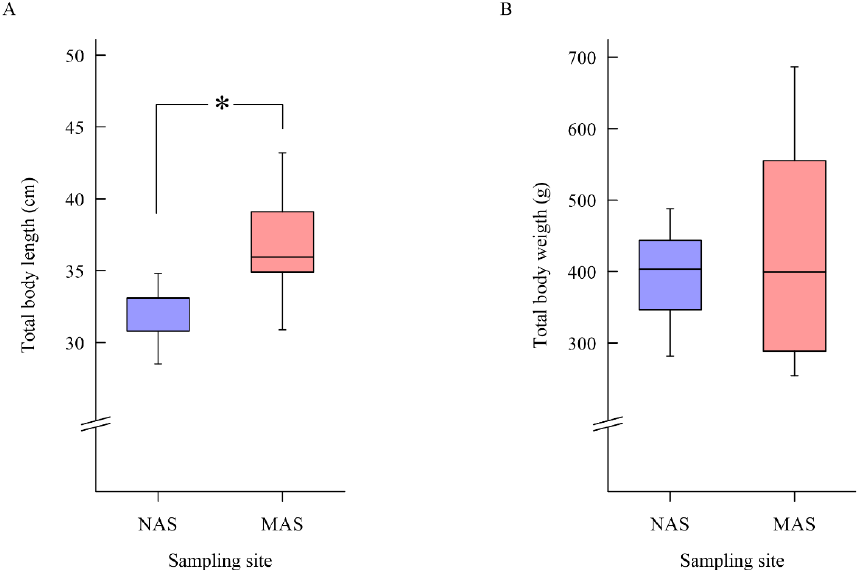
Figure 2. ( A ) The total body length (cm) and ( B ) the total body weight (g) of sea bass (N = 10) from sites NAS ( (cid:4) ) and MAS ( (cid:4) ). Square boxes indicate the lower and upper quartiles and the whiskers represent the minimum and maximum data values (1.5 interquartile range). The medians are depicted by a solid line. * Significant difference ( p < 0.05) between the